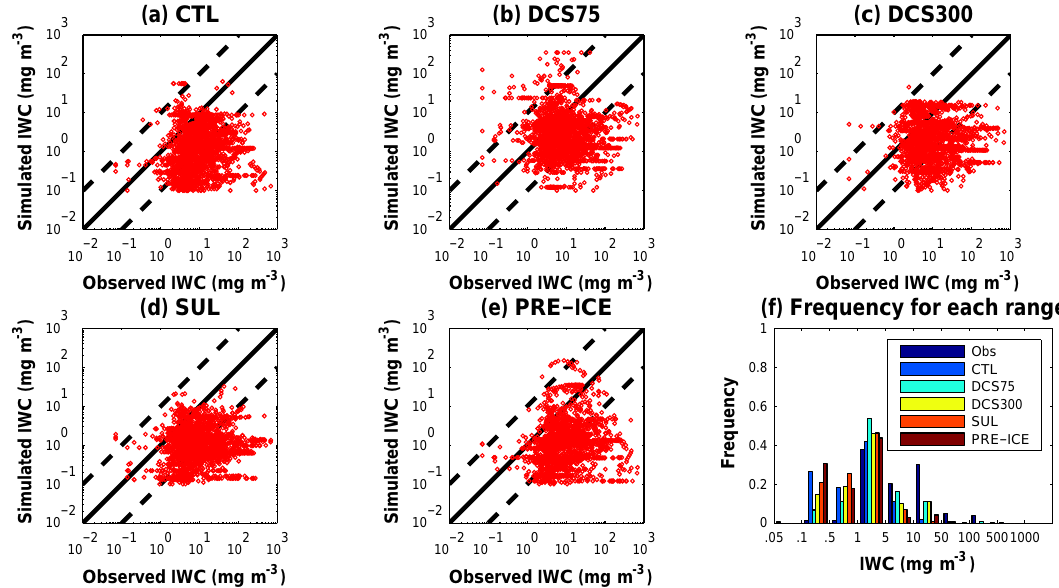
Figure 10. As Fig. 8 but for the comparison of ice water content (IWC).